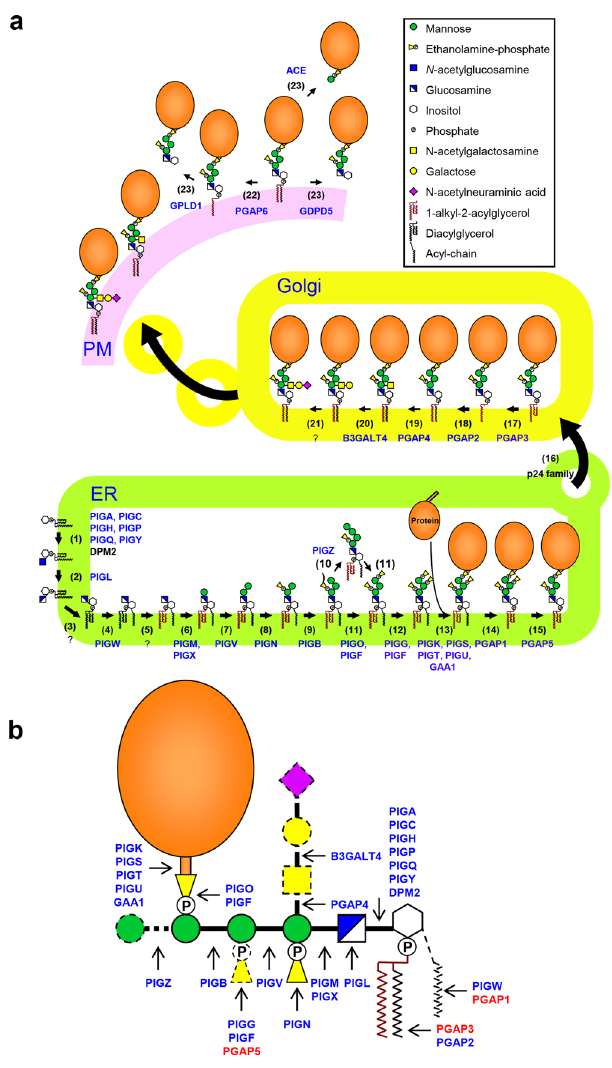
Fig. 1 The biosynthesis of GPI-APs in mammalian cells. a GPI biosynthesis is carried out in the ER, Golgi, and the cell surface through a series of catalytic reactions. It starts with the transfer of GlcNAc to PI. The fi rst two steps occur on the cytoplasmic side of the ER, and then the modi fi cation of polysaccharides and lipids occurs on the luminal side of the ER and Golgi. Proportions of GPI-APs further undergo side chain modi fi cation. Gene products that were knocked out in this study are highlighted in blue. b Schematic representation of a human GPI-AP structure. Gene products required for the synthesis of the GPI structure are shown in blue, and gene products that remove the structure are shown in red. The solid lines of the GPI structure indicate the core structure in human cells, whereas the dotted lines indicate accessory structures observed in human